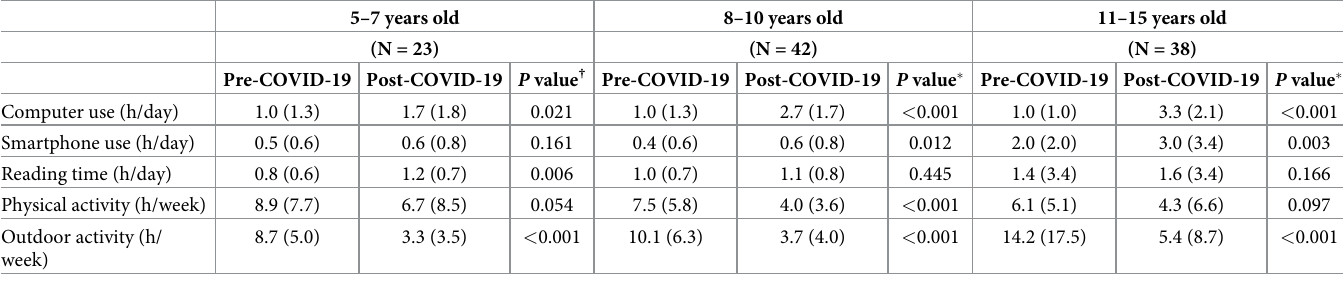
Table 5. Questionnaire according to children’s